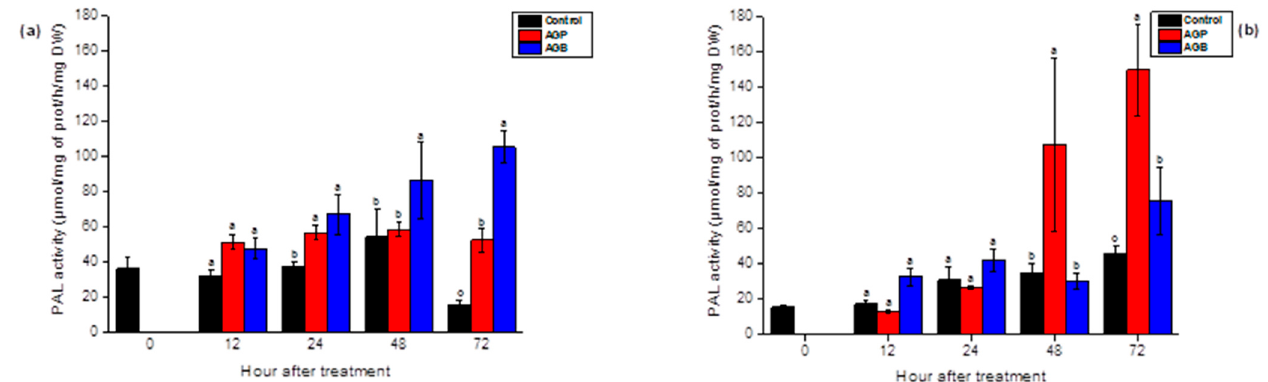
Figure 4. Stimulation of PAL activity in the leaves ( a ) and the roots ( b ) of tomato seedlings after injection (10 µ L) of AGB and AGP fractions (1 g/L). Each value is the mean of four repetitions ± SE. The letters (a, b, c) indicate significant differences between treatments (Control, AGB, and AGP) in each point time using Tukey–HSD test, at ( p < 0.05). Treatments presented with the same letter are not significantly different.